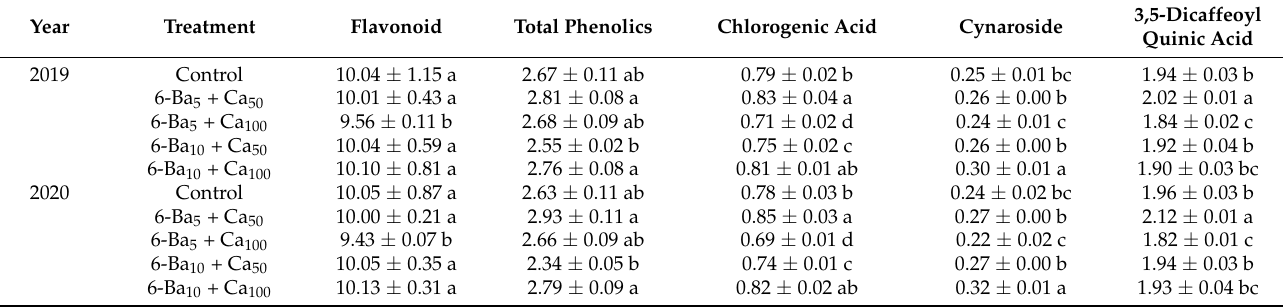
Table 4. Changes of medicinal quality index of Hangbaiju flowers